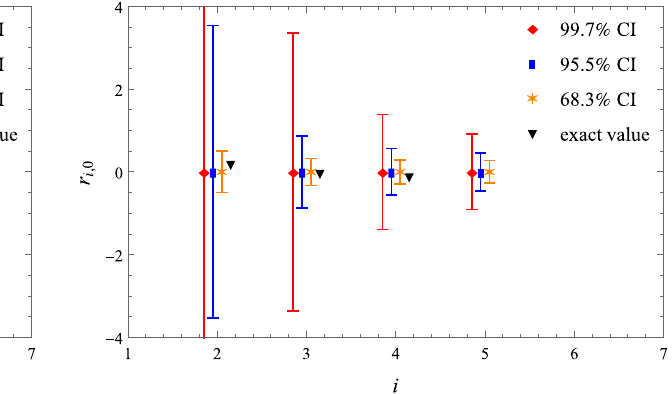
the golden yellow stars and the black inverted triangles together with their error bars, are for 99 . 7% CI, 95 . 5% CI, 68 . 3% CI, and the exact values of the coefficients at different orders,